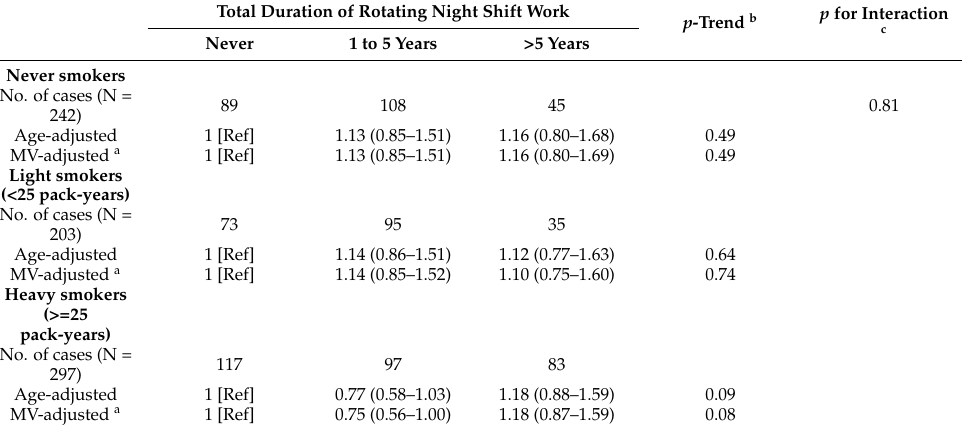
Table 3. Hazard ratios (HR) and 95% confidence intervals (CI) of bladder cancer risk according to the total duration of rotating night shift work in the pooled NHS and NHS II, stratified by baseline smoking status. Total Duration of Rotating Night Shift Work p -Trend b p for Interaction